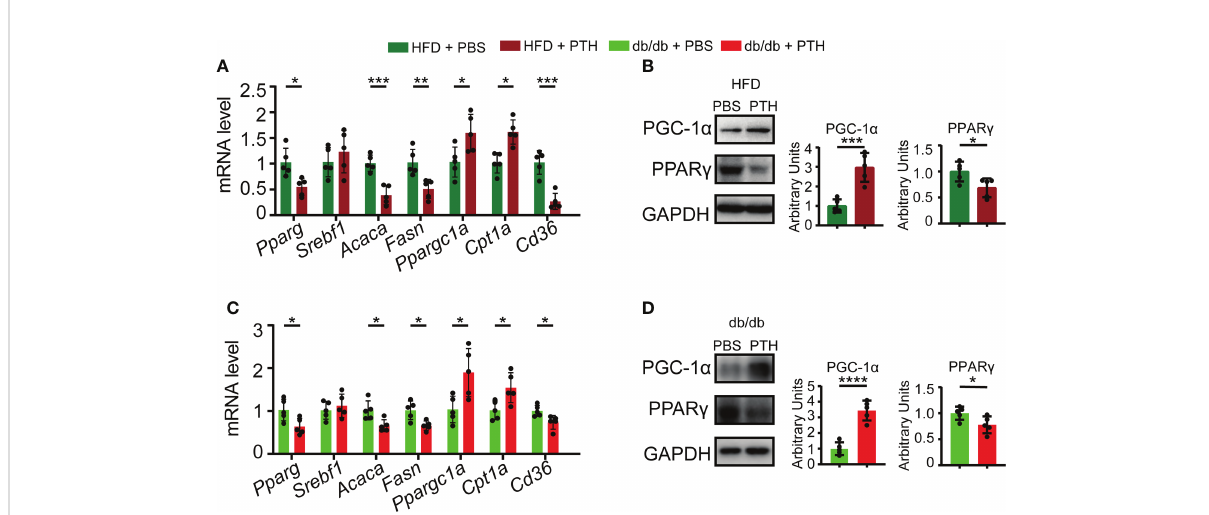
FIGURE 4 Effects of PTH on hepatic lipid metabolism-related genes. (A) The mRNA levels of genes involved in de novo lipogenesis, b -oxidation, and uptake of lipid in the liver of DIO mice injected with PTH or PBS as indicated. (B) The protein levels of PGC-1 a and PPAR g in the liver of DIO mice injected with PTH or PBS as indicated. (C) The mRNA levels of genes involved in de novo lipogenesis, b -oxidation, and uptake of lipid in the liver of db/db mice injected with PTH or PBS as indicated. (D) The protein levels of PGC-1 a and PPAR g in the liver of db/db mice injected with PTH or PBS as indicated. Data are shown as mean ± SD (n=5/group). *p < 0.05; **p < 0.01; ***p < 0.001; ****p < 0.0001 by two-tailed Student ’ s